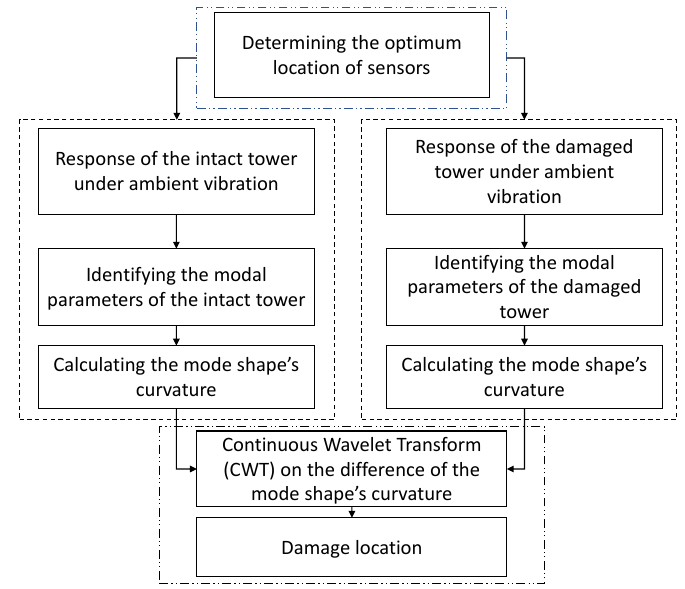
Figure 2. Main algorithm of the proposed